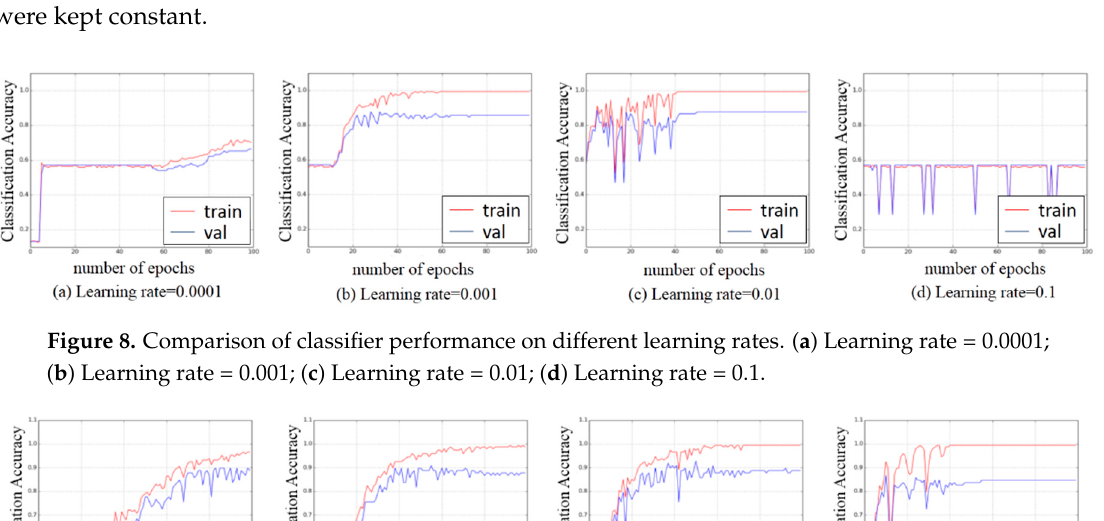
( b ) Learning rate=0.001; ( c ) Learning rate=0.01; ( d ) Learning rate=0.1.